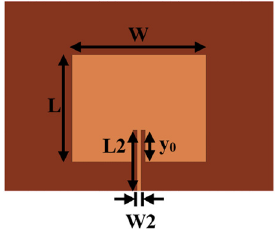
Figure 2. Antenna design parameters based on PI substrate.